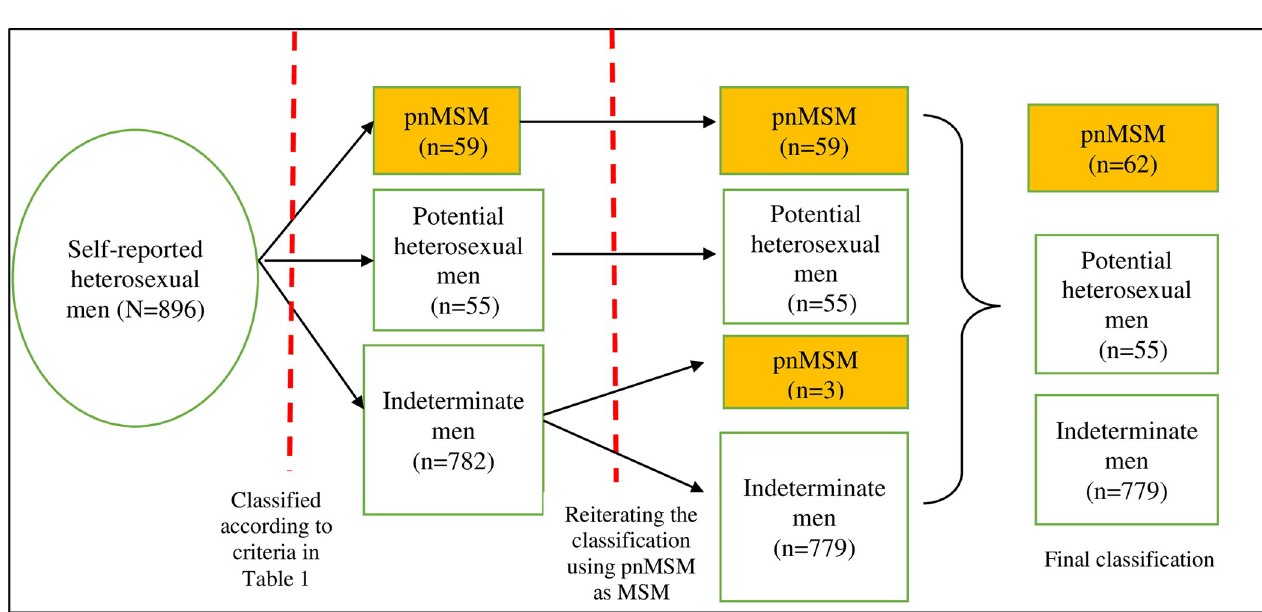
Fig 1. Classification of potential non-disclosed men who have sex with men (pnMSM) identified from clusters containing self-reported heterosexual men with HIV and related nodes in the genetic network using a genetic distance threshold of 0.75% substitutions/site.